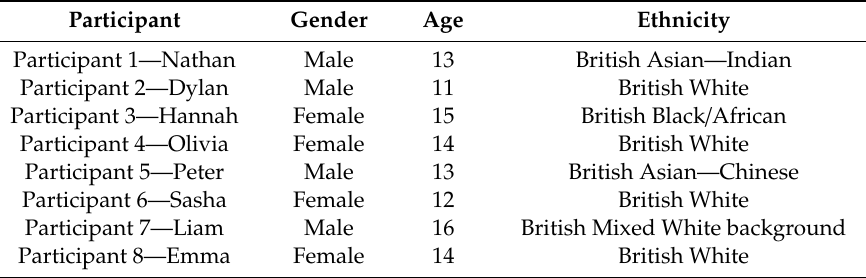
Table 1. Descriptive details of participants using pseudonyms ( n =